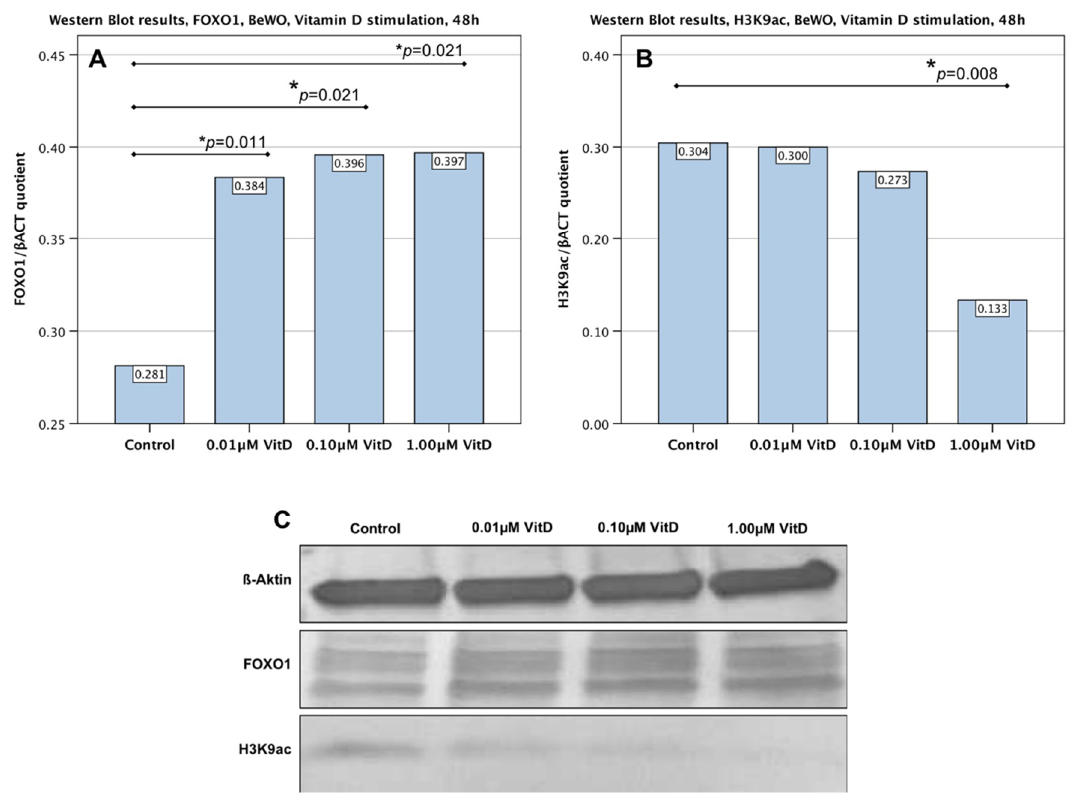
Figure 3. Western Blot analysis of FOXO1 and H3K9ac expression in BeWo cells after 48 h stimulation with human calcitriol. ( A ) Bar graph diagram showing a significant ( p = 0.011 corresponding to 0.01 µM, p = 0.021 corresponding to 0.1 µM, p = 0.021 corresponding to 1.0 µM), dose-dependent upregulation of FOXO1 after 48 h stimulation with human calcitriol. ( B ) Bar graph diagram showing a significant ( p = 0.008) downregulation of H3K9ac after 48 h stimulation with human calcitriol at 1.0 µ M. No significance was shown for stimulation with 0.01 nor 0.1 µ M. ( C ) Representative photographs of the western blot membrane with detected bands for H3K9, FOXO1 and endogenous control (β- Actin) .